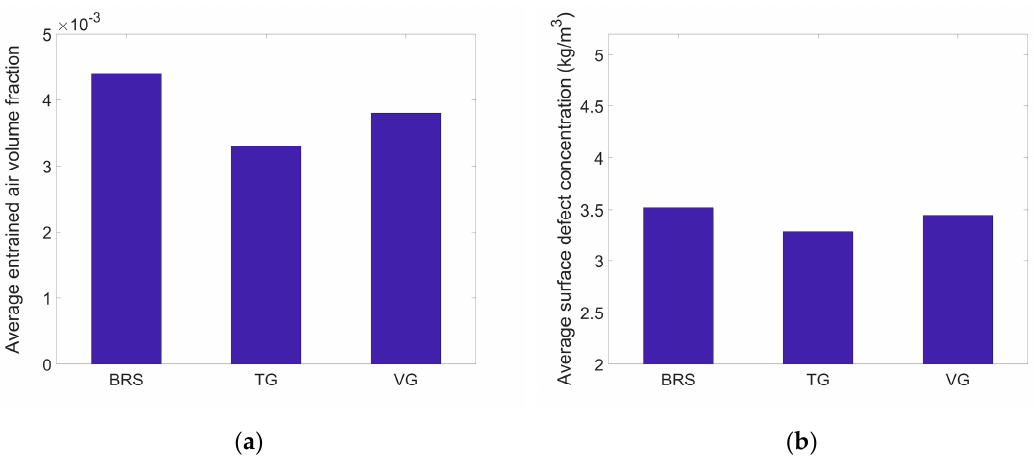
Figure 11. ( a ) Average entrained air volume fraction and ( b ) average surface defect concentration for the basic running system (BRS), trident gate (TG) and vortex gate (VG) designs with a mass source velocity of 1.5 m / s.